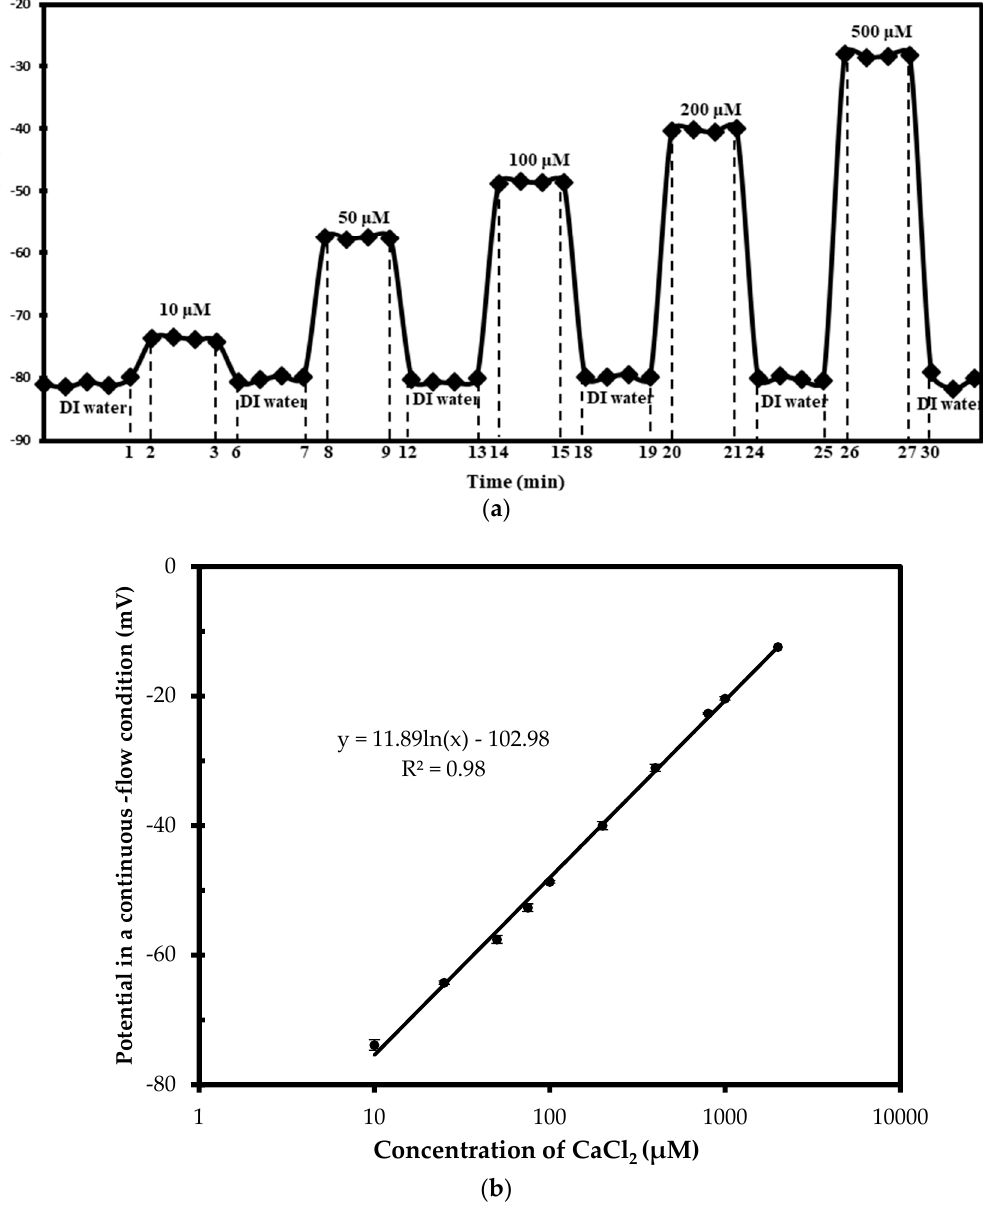
Figure 2. ( a ) The potential measured in a continuous-flow condition for different concentrations of calcium chloride (10 µ m–500 µ M); ( b ) The potential of the Ca-ISE for calcium chloride at the concentrations from 10 µ M to 2 mM ( N = 3).